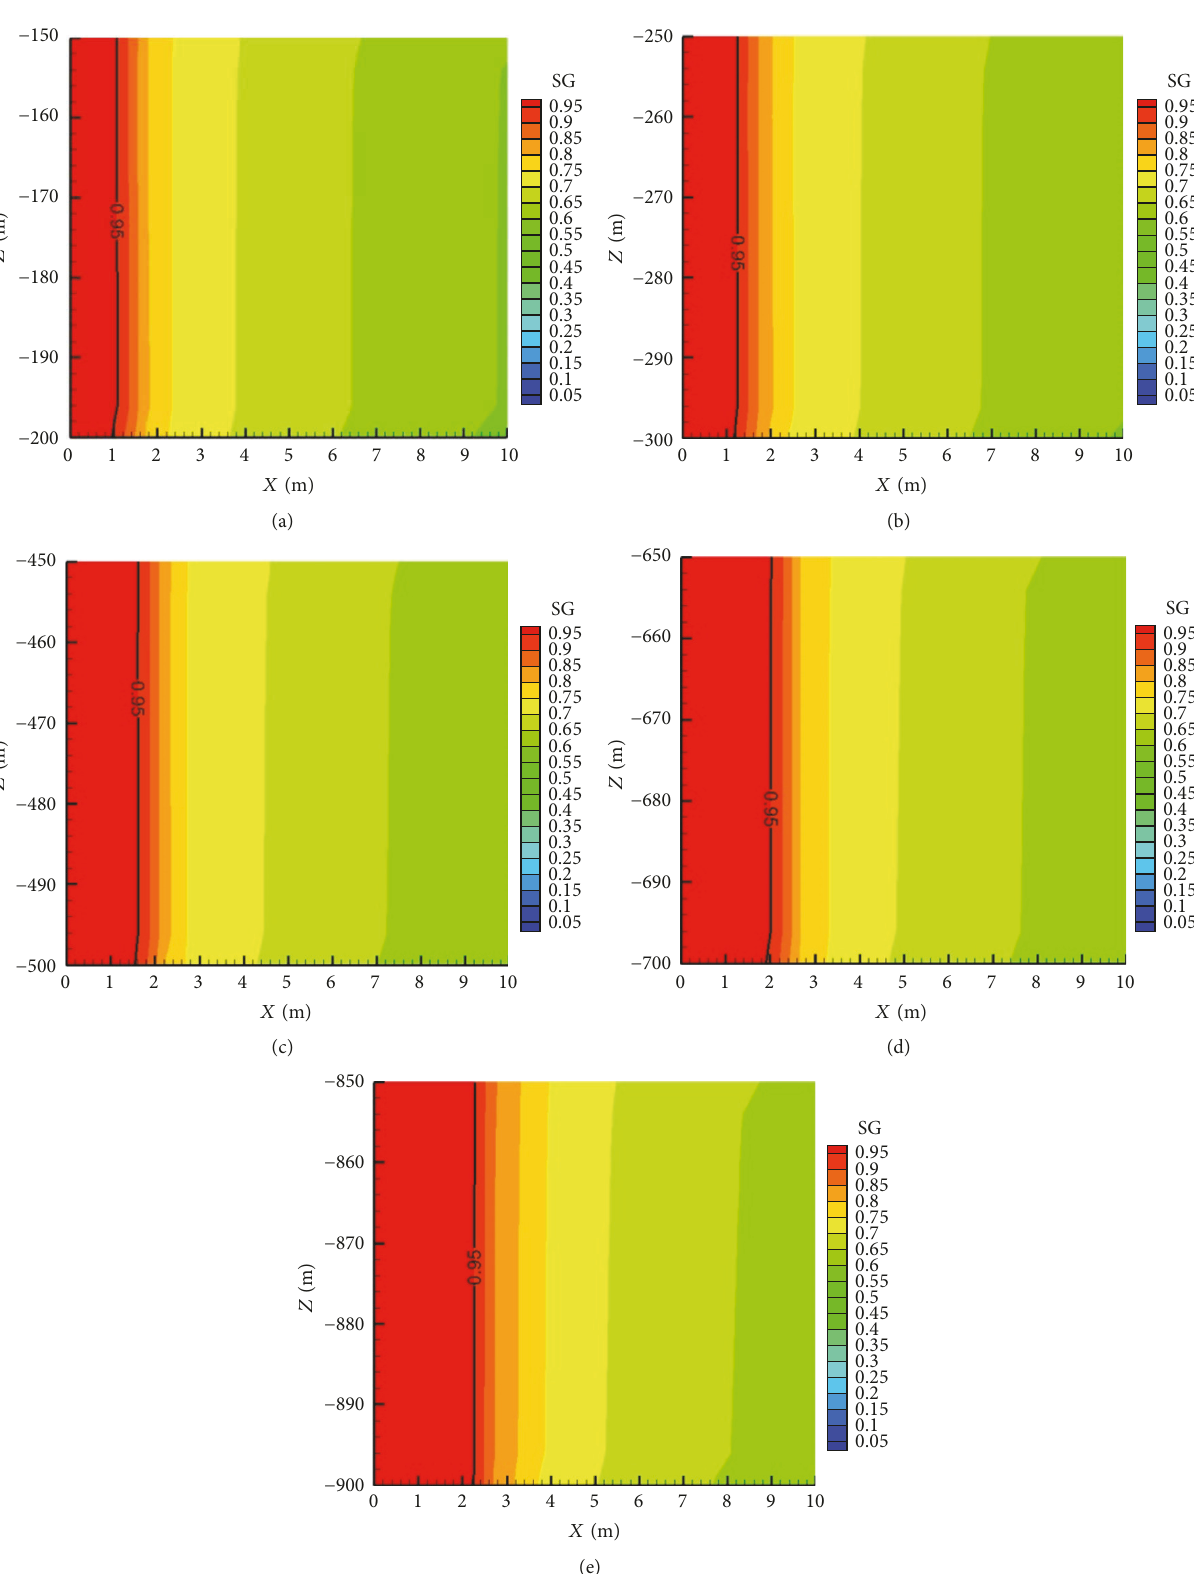
Figure 12: Distribution of the initial gas saturation within a lateral distance of 10m before the cycle process for five cases. (a) Case 4 (150m–200 m); (b) Case 5 (250 m–300 m); (c) Case 6 (450 m–500 m); (d) Case 7 (650m–700 m); (e) Case 8 (850 m–900